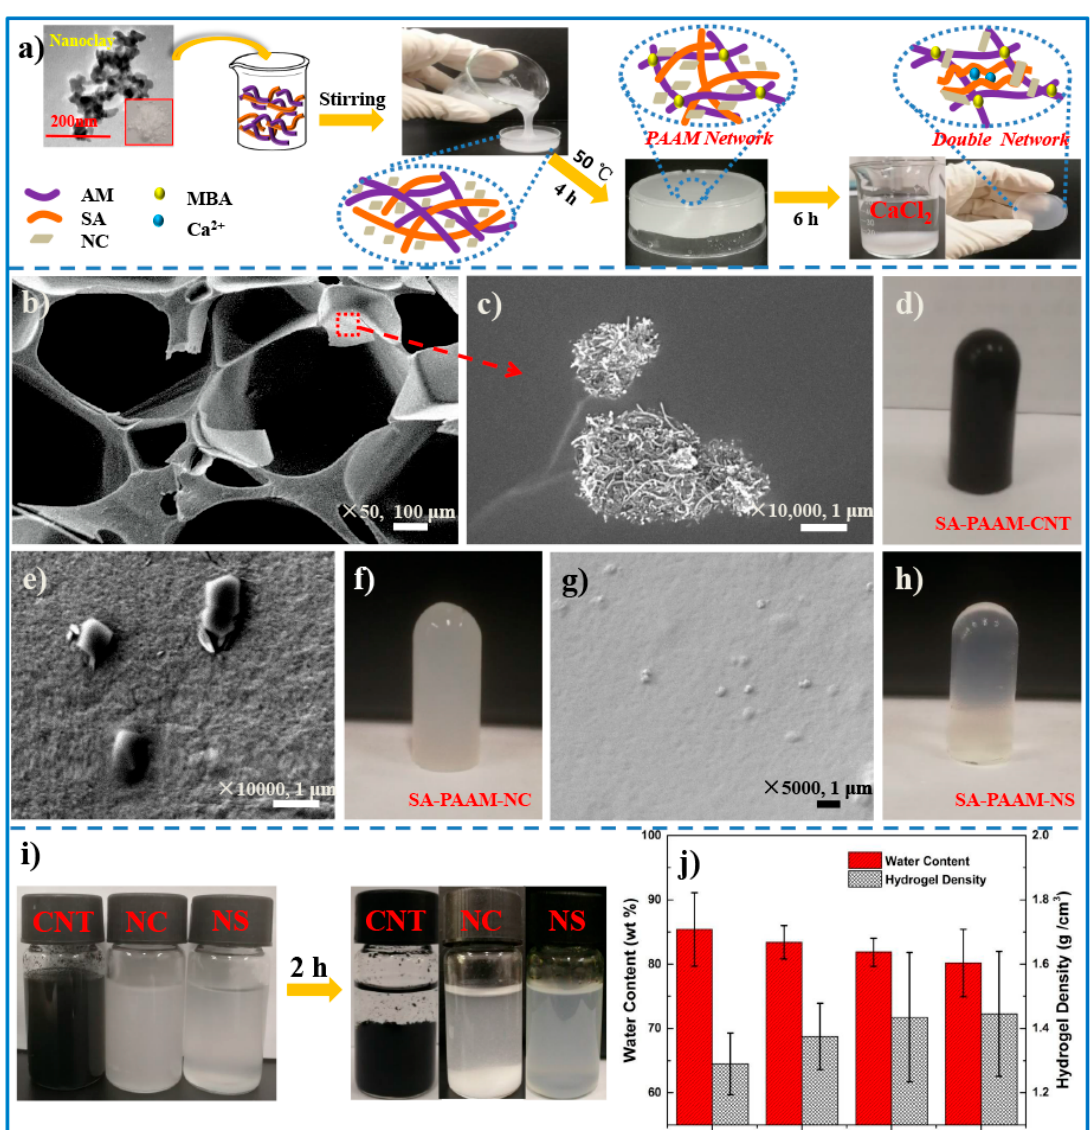
Figure 1. The morphology of hydrogels : ( a ) schematic illustration of the hydrogel fabrication; ( b ) SEM photographs of freeze-dried interpenetrating polymer network (IPN)-structured hydrogels; amplified view of ( c ) carbon nanotubes (CNTs), ( e ) nanoclays (NCs), and ( g ) nanosilicas (NSs) distributed in polymer matrix; photographs of ( d ) PAAM-SA-CNT, ( f ) PAAM-SA-NC and ( h ) PAAM-SA-NS; ( i ) appearance of CNT, NC, NS suspensions after 2 h of settling; ( j ) water content and density of hydrogels.